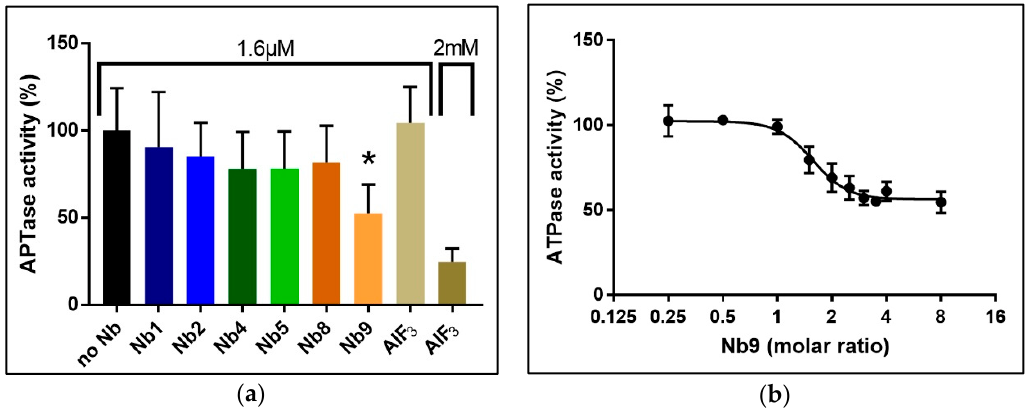
Figure 10. Nanobody effect on the catalytical function. ( a ) SsZntA was incubated with each Nb at a 1:2 molar ratio (i.e., 1.6 μ M) and activity was assessed. Nb9 displayed an inhibitory effect of about 50% compared to untreated (no Nb) SsZntA. The difference between no Nb and Nb9 has a p value of <0.0001 (*), as assessed by a Dunn’s multiple comparison test. The ATPase inhibitor aluminum fluoride (AlF 3 ) is shown as a positive control, at 1.6 μ M (corresponding to the concentration of the tested Nbs) and at 2 mM. ( b ) The inhibition stoichiometry was assessed as titration of SsZntA with different molar ratios of Nb9. The inhibitory effect appears when Nb9 is present at a molar ratio of 1:1 (ZntA:Nb9), and reaches the inhibitory plateau at a molar ratio of 1:3 (ZntA:Nb9), with an IC 50 = 1.57 molar ratio.